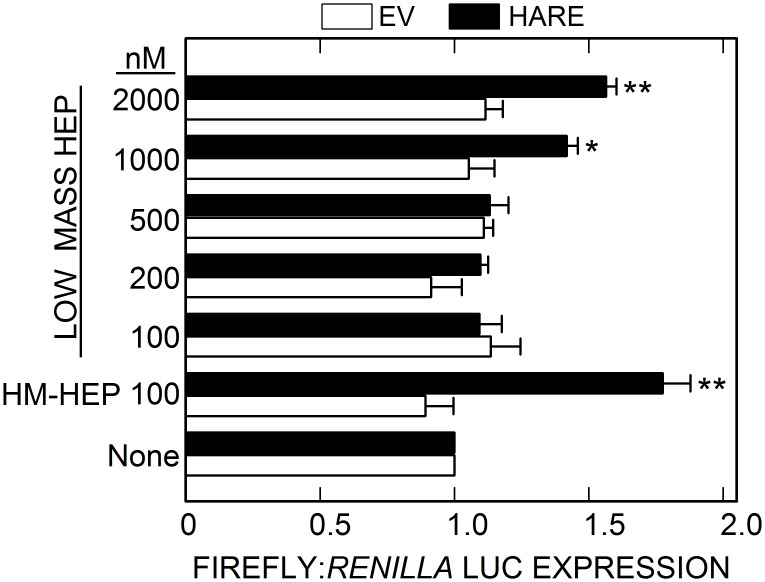
Low mass Hep stimulates HARE-mediated NF-κB activated gene expression less effectively than UFH.Cells expressing EV (white bars) or WT (black bars) HARE were grown and transfected with LUC recorder gene plasmids as described in Methods. The cells were incubated at 37°C for 4 h with 100 nM UFH or increasing concentrations of LMWH, as indicated, and then processed and analyzed for relative LUC activities. Values are the means ± SEM (n = 9) of the ratio of the two LUC activities determined from three independent experiments, with the value for unstimulated cells set as 1.0. Values for p compared WT cells with EV cells for each condition (*, p < 0.05; **, p 0.005) using ANOVA.